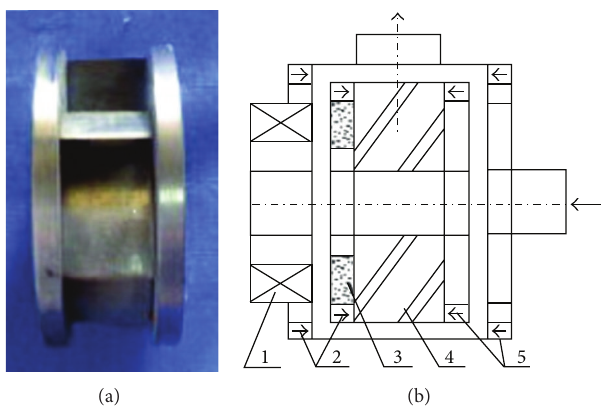
Figure 26: Permanent maglev centrifugal pump (b) and its impeller (a), (1) motor coil; (2) passive magnetic bearing; (3) rotor magnets; (4) impeller; (5) passive magnetic bearing.